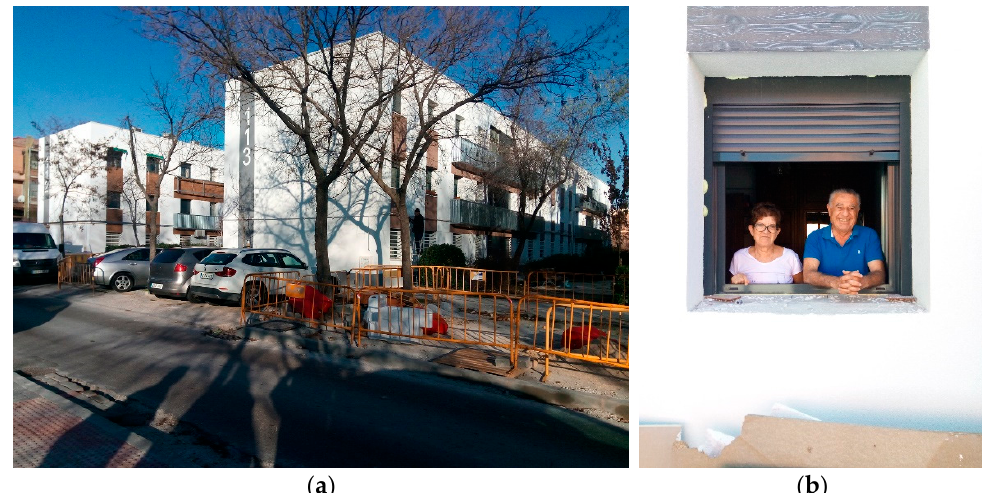
Figure 9. Barajas urban regeneration and integrated rehabilitation project ( a ) and neighbors ( b ), Madrid, Spain. Courtesy of Mireya Reguart and José Luis Delgado.